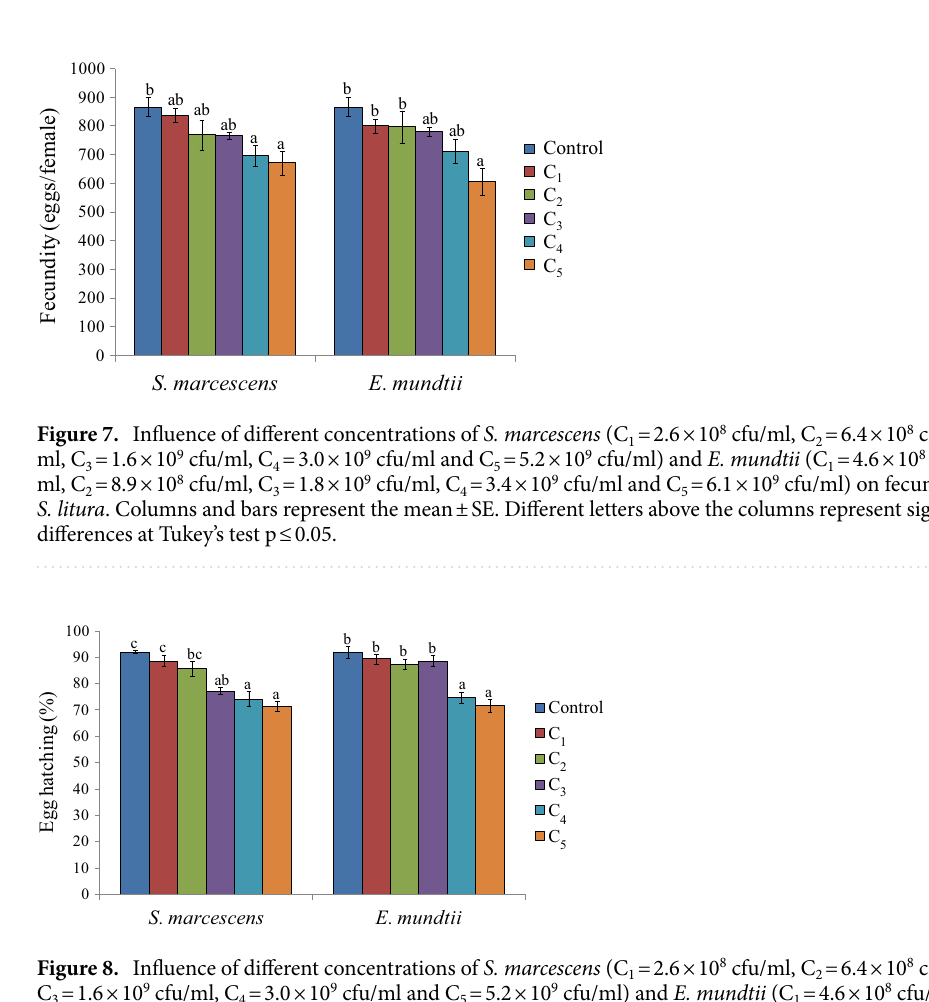
Figure 6. Influence of different concentrations of S. marcescens (C 1 = 2.6 × 10 8 cfu/ml, C 2 = 6.4 × 10 8 cfu/ml, C 3 = 1.6 × 10 9 cfu/ml, C 4 = 3.0 × 10 9 cfu/ml and C 5 = 5.2 × 10 9 cfu/ml) and E. mundtii (C 1 = 4.6 × 10 8 cfu/ml, C 2 = 8.9 × 10 8 cfu/ml, C 3 = 1.8 × 10 9 cfu/ml, C 4 = 3.4 × 10 9 cfu/ml and C 5 = 6.1 × 10 9 cfu/ml) on adult longevity of S. litura . Columns and bars represent the mean ± SE. Different letters above the columns represent significant differences at Tukey’s test p ≤ 0.05.